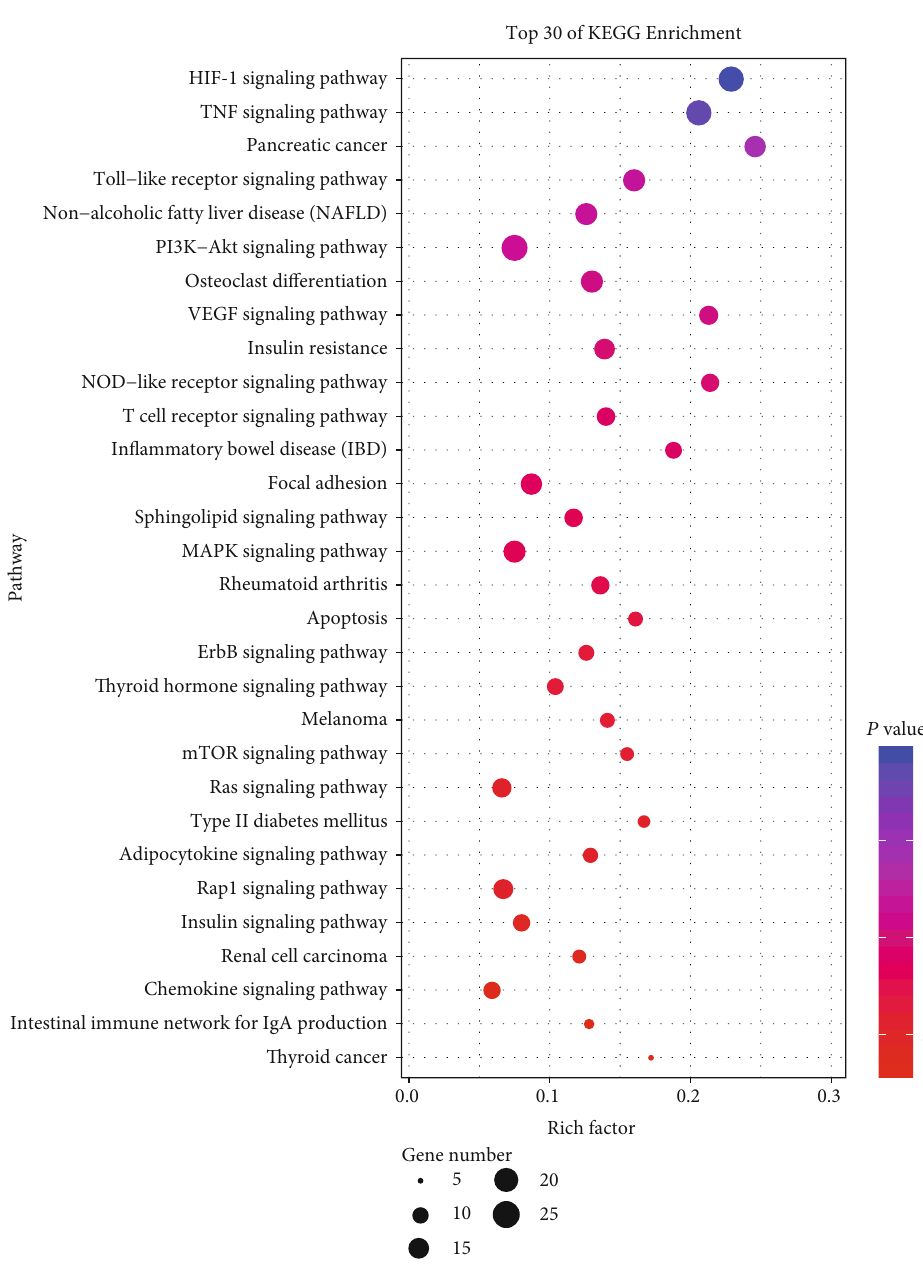
Figure 9: Enriched KEGG terms for TSF on treatment of DN. The P value means − Log and the color of the circle means the value of − Log